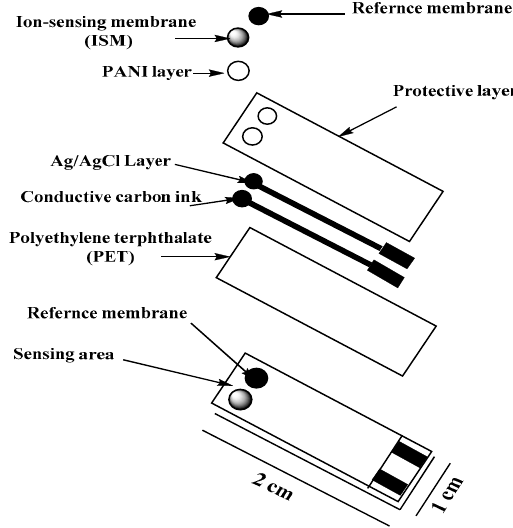
Figure 1. Scheme of the different layers, and final design of the potentiometric strip cell.